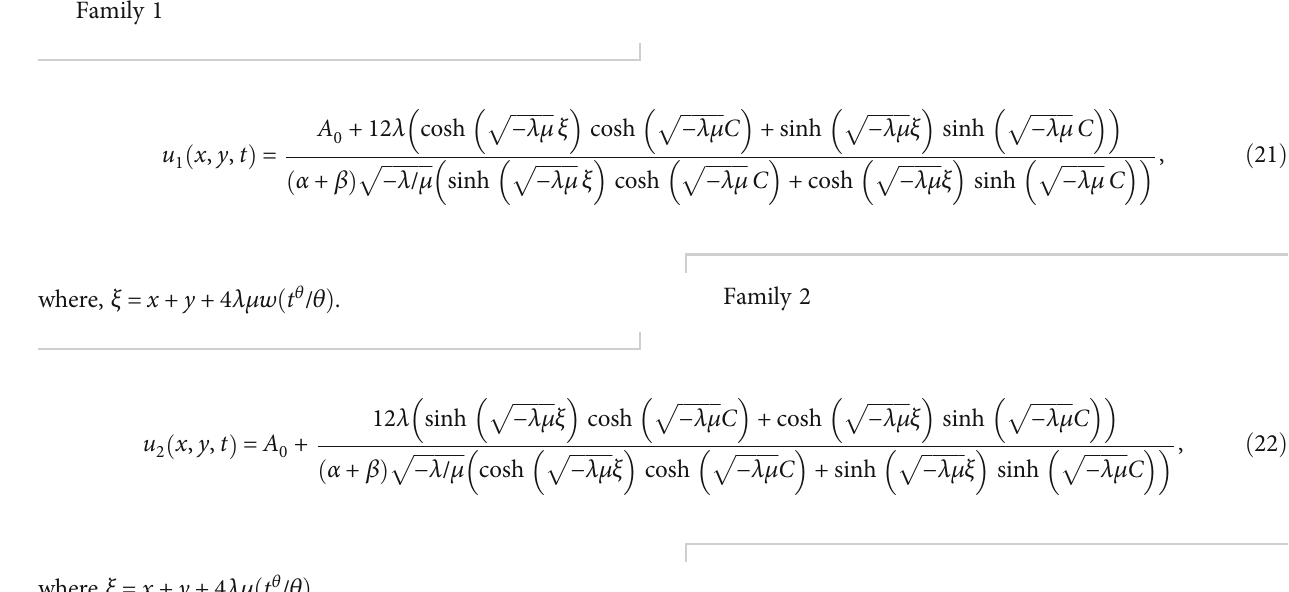
Figure 9: Dynamical behavior of function solution of u